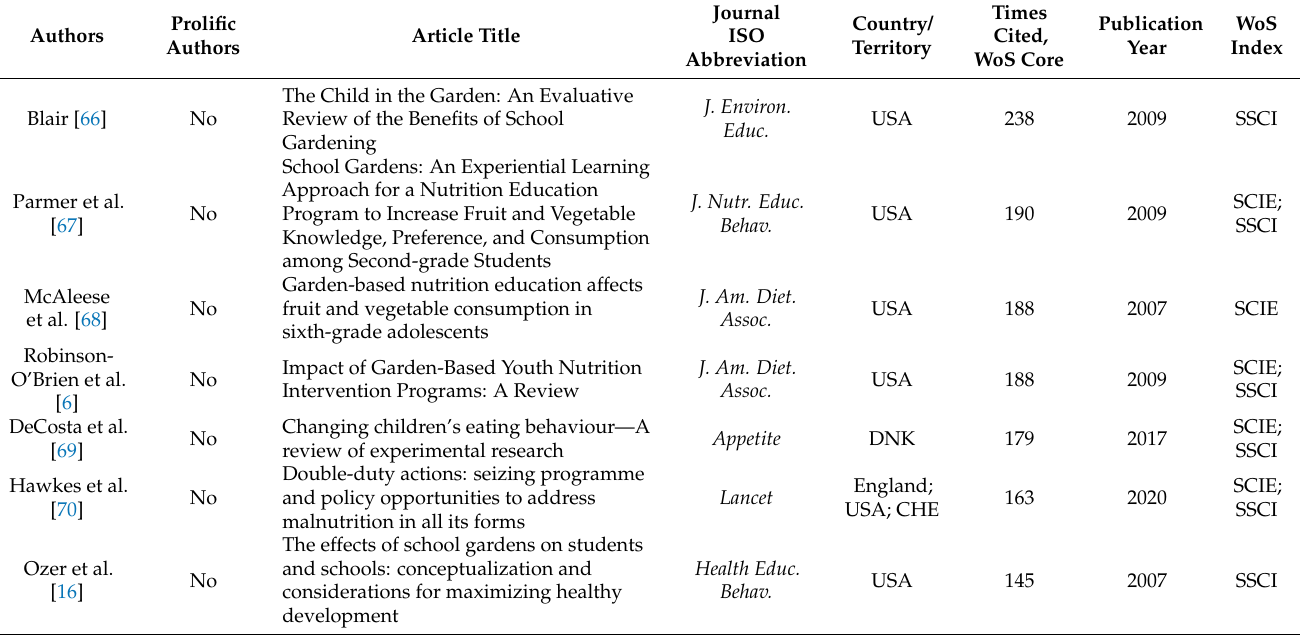
Figure 5. h-index estimation. Table 2. h-index articles (38 or more